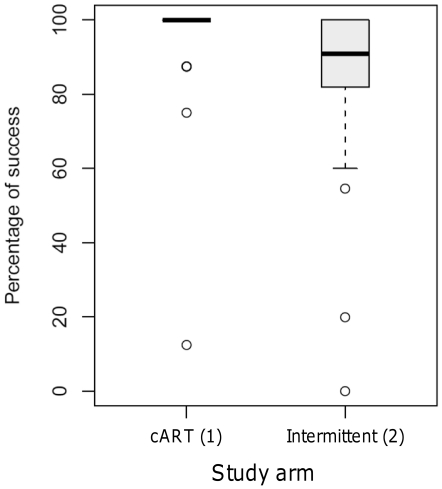
Primary study outcome.The box plot represents the percent of successful outcomes (CD4+ T cell count >350 cells/µl)over all post-randomization visits in the two study arms; boxes represent 5th, 25th, 50th (median), 75th and 95th percentiles. Outliers are represented as individual circles.